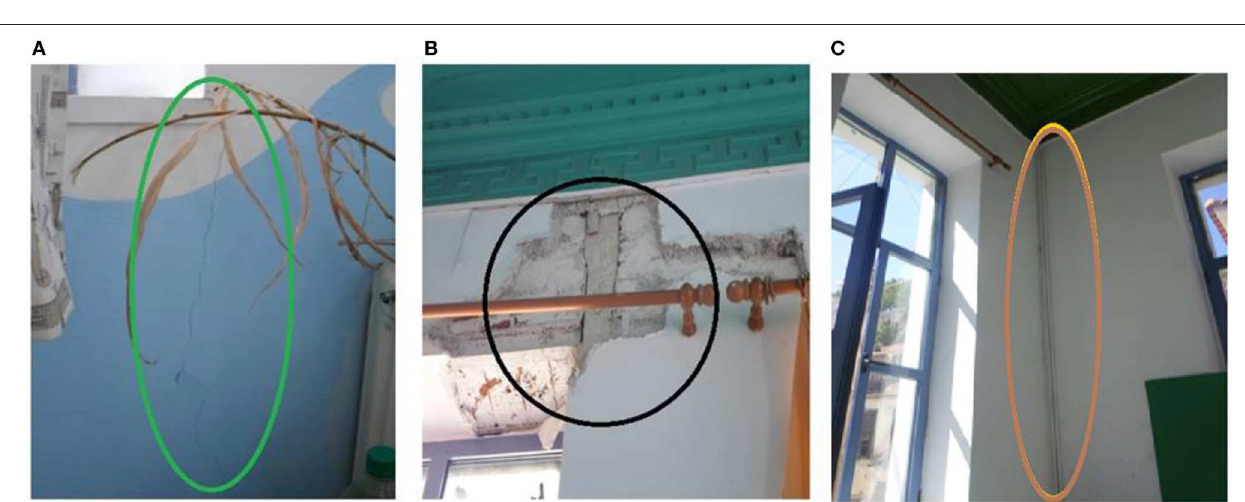
forces induced by the earthquake to all masonry walls, of the walls perpendicular to the seismic